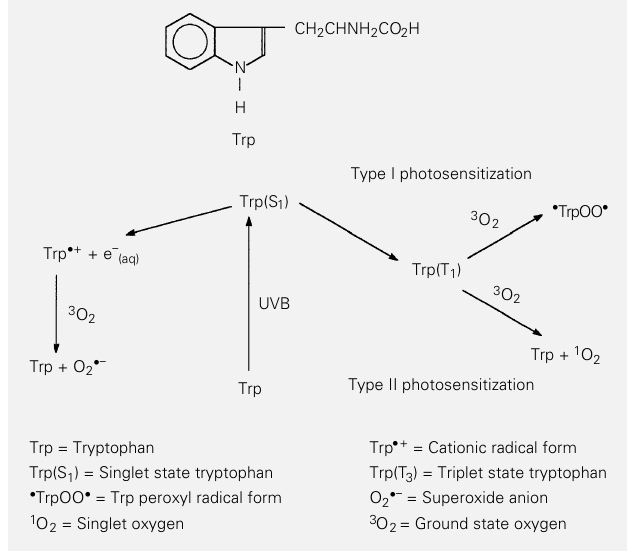
Figure 1 - Photooxidative reaction of